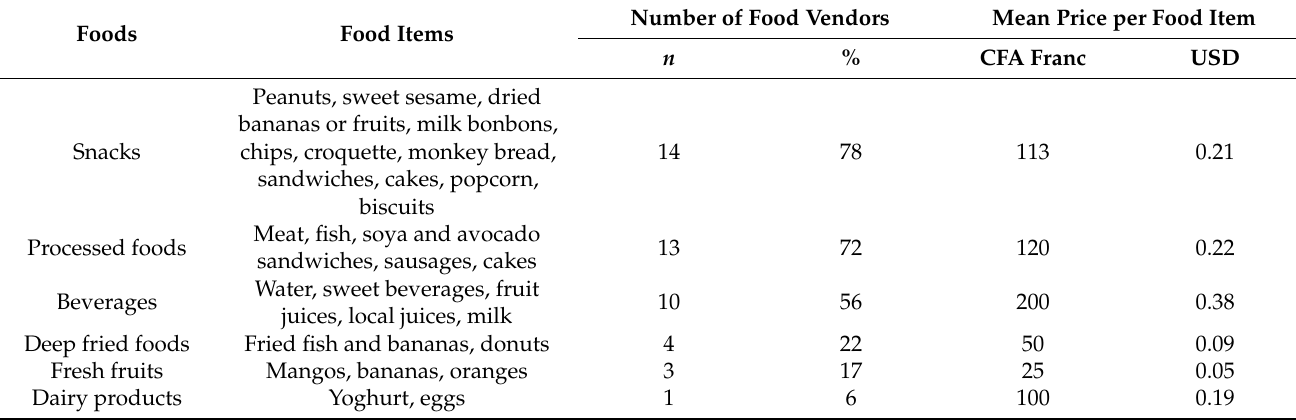
Table 6. Food items sold on the day of the survey and their mean price as reported by 18 food vendors located in and around junior secondary schools in